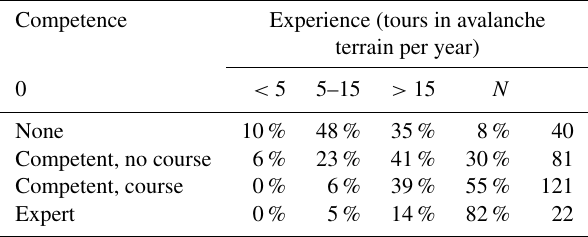
Table 4. Contingency table of user respondents’ experience (num- ber of tours in avalanche terrain per year) versus competence.